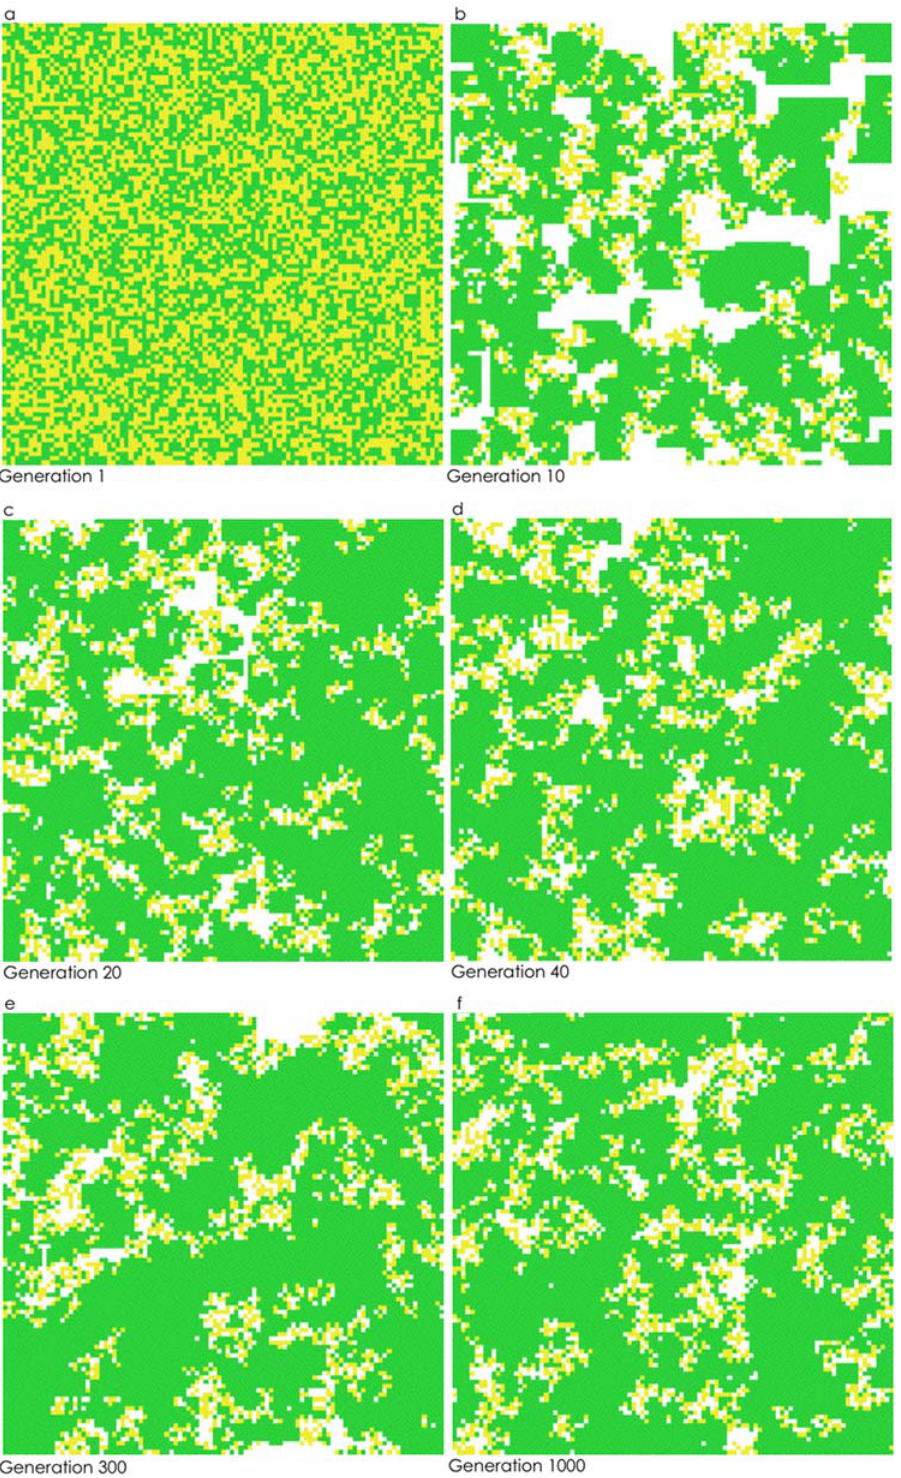
Figure 1. Two-dimensional snapshots of the 10,000 slot torus. B/C=0.62, help=0.14 (this ‘‘help’’ value was chosen, in part, as the result of unpublished experimental work on b –lactamase secretion in producer cells). a ) Generation 1, b ) Generation 10, c ) Generation 20, d ) Generation 40, e ) Generation 300 and f ) Generation 1000. Note that for generations 1–999, any yellow (nonproducers) cells surrounded by only yellow or by only yellow and white cells would die and be replaced the next generation.